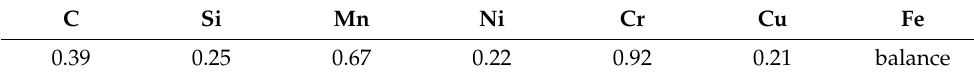
Figure 3. Scheme pin-on-disk of the friction test. Table 1. Chemical composition (wt.%) of the steel counterbody (Standard RF